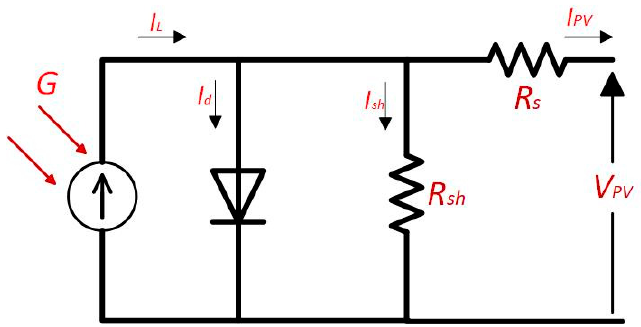
Figure 2. Equivalent circuit of PV cell [7].